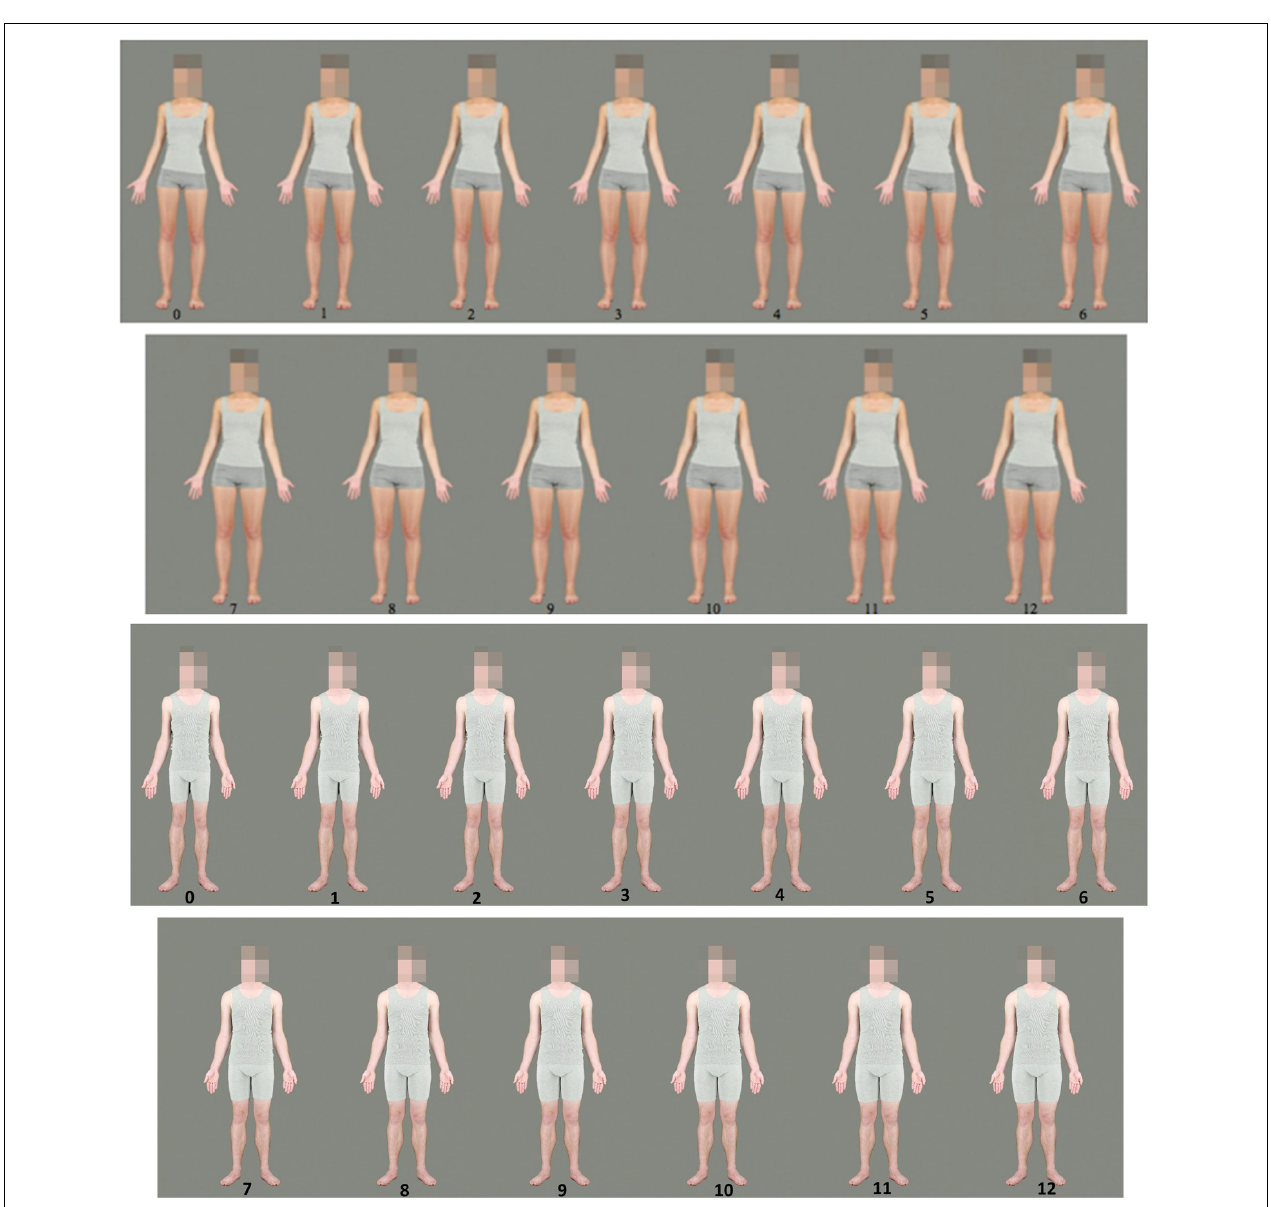
FIGURE 2 | An example of a transformed female body (top) and male body (bottom). Frame 0 has been reduced by 12 kg of fat, Frame 12 has been increased by 12 kg. Each step represents a change of 2 kg fat